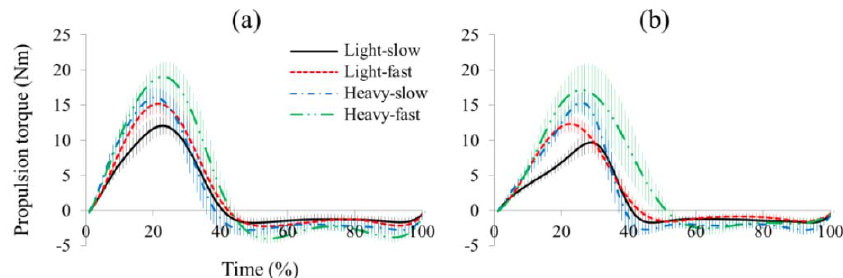
Figure 4. Mean propulsion torques for (a) unskilled and (b) skilled groups during manual wheelchair propulsion under four different